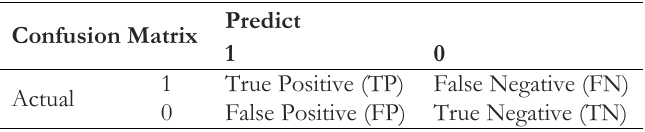
Table 1. Confusion